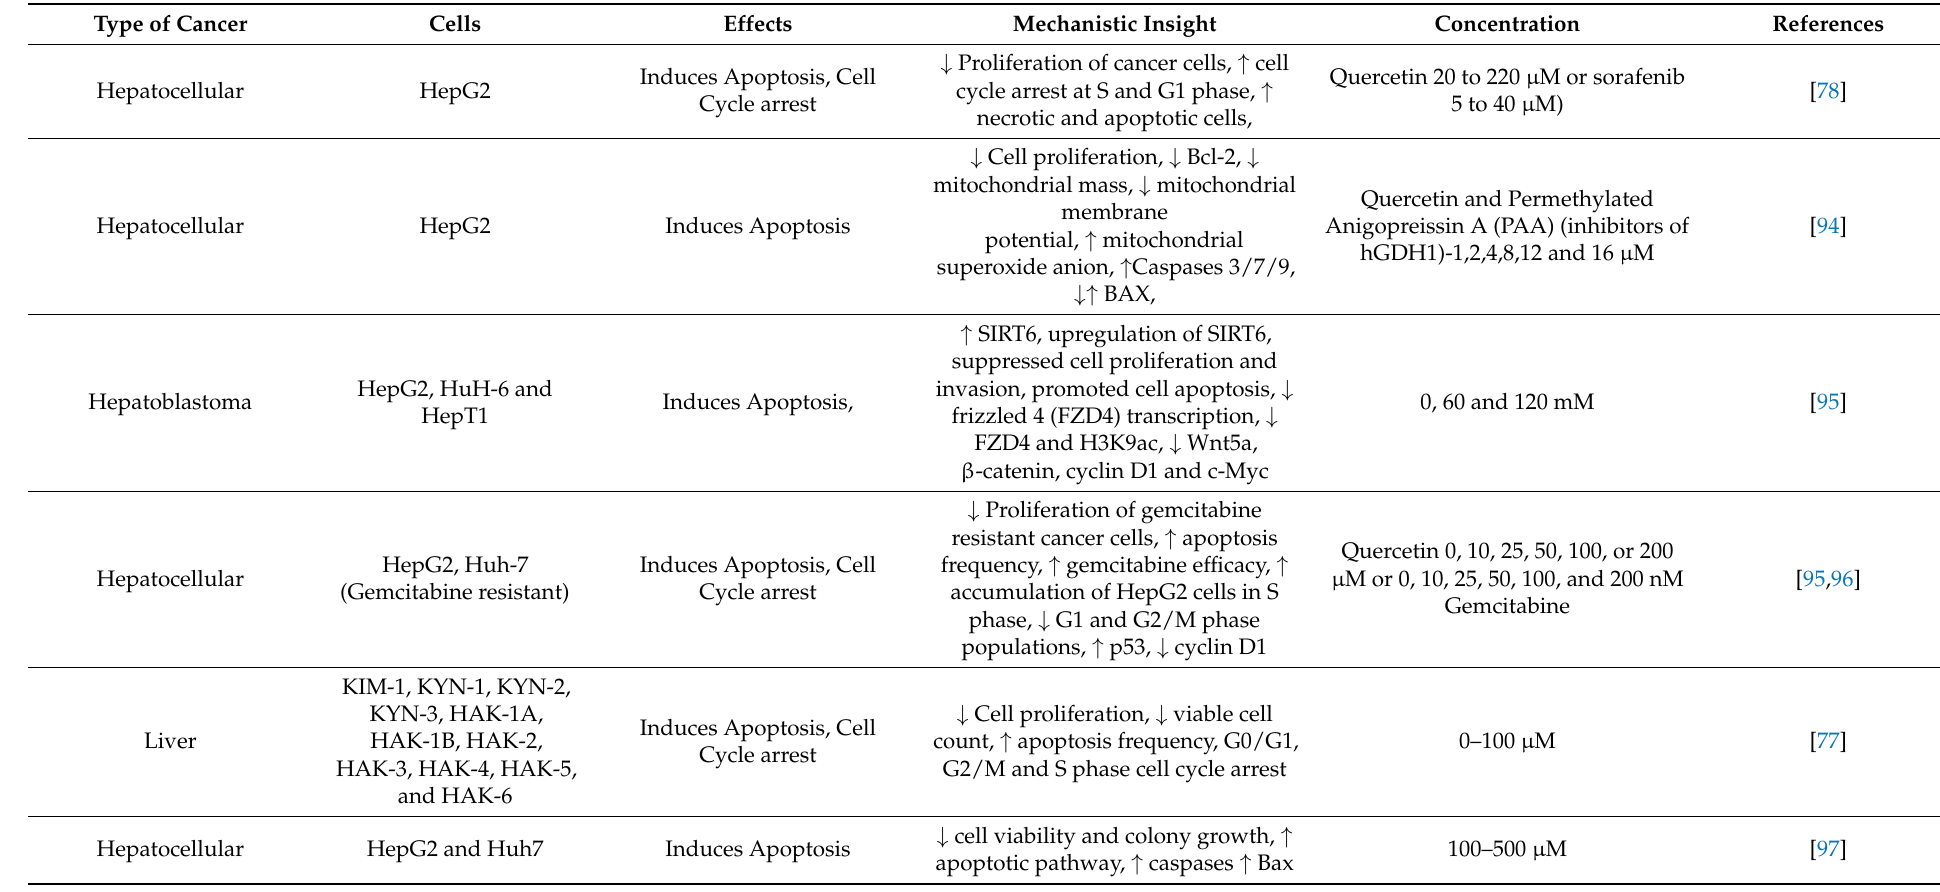
Table 2. Preclinical studies showing apoptotic effects of quercetin on liver